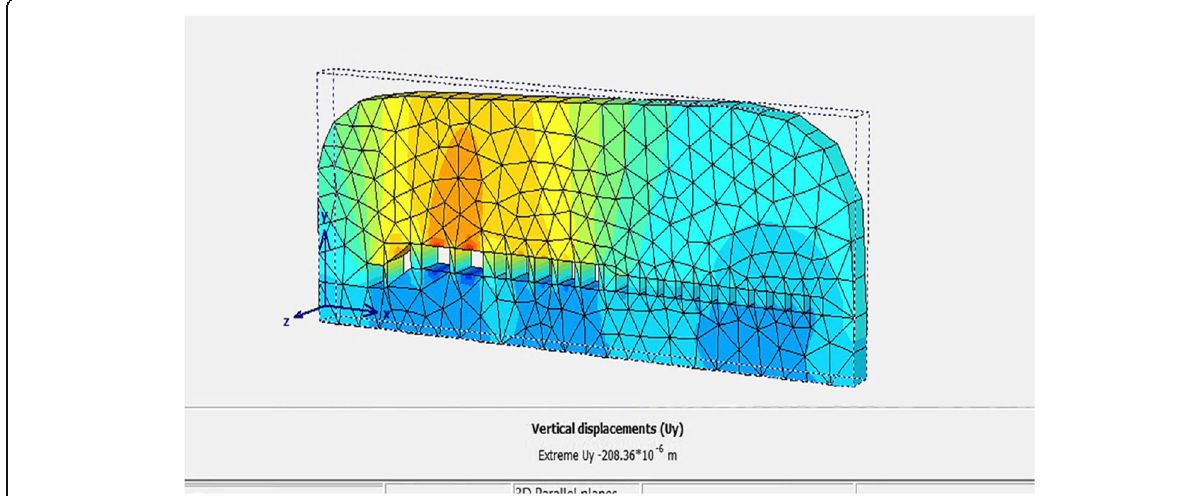
Fig. 25 Vertical displacement of rock pillars in Chamber 3and others small burial chambers